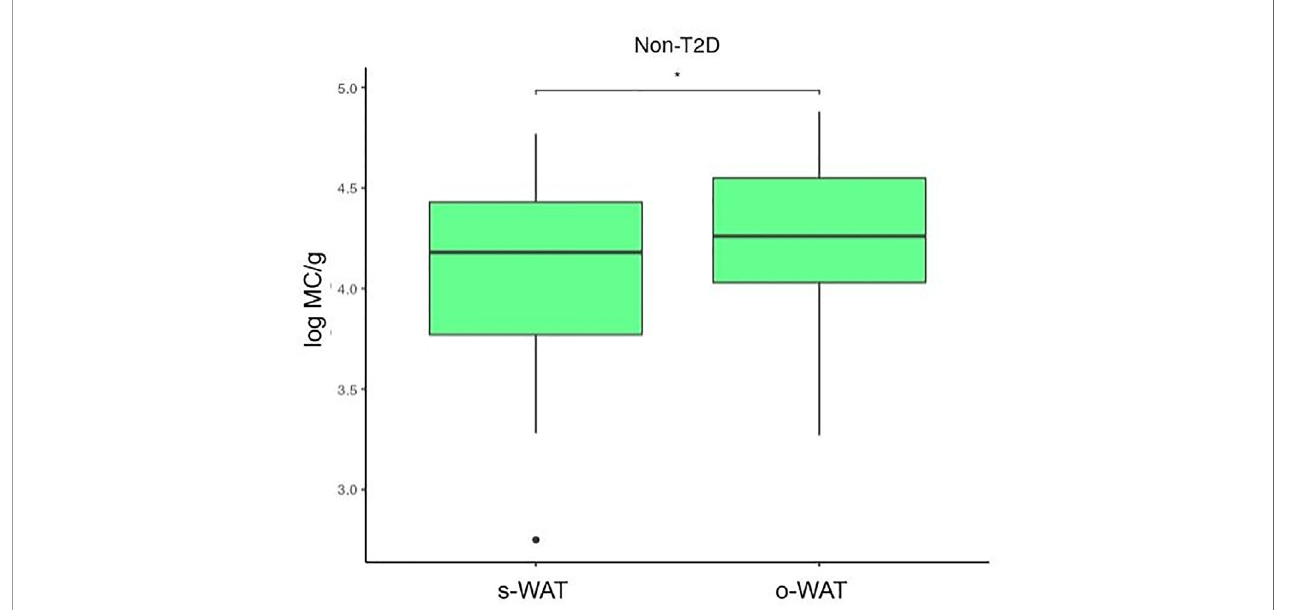
FIGURE 4 | Differences in mast cells per gram of tissue between subcutaneous and omental white adipose tissue in patients without type 2 diabetes. The data comes from the big cohort (n = 100). MC (mast cells), s-WAT (subcutaneous white adipose tissue), o-WAT (omental white adipose tissue), T2D (type 2 diabetes), “ * ” (0.05 > p-value >